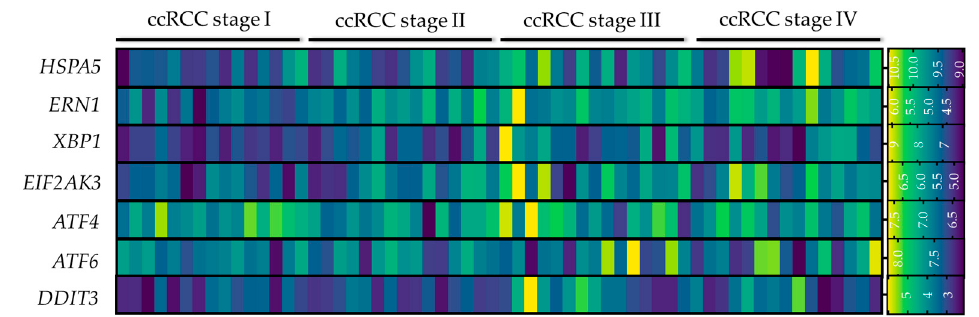
Figure 7. Expression of ER stress mediators in human ccRCC biopsies segregated in different stages. Heatmap representation of the expression of HSPA5 (encoding GRP78), ERN1 (encoding IRE1 α ), XBP1 , EIF2AK3 (encoding PERK), ATF4 , ATF6 and DDIT3 (encoding CHOP) in human ccRCC biopsies at stage I, II, III and IV ( n = 15/group). The data were acquired from the GEOdataset GSE150404 (expression profiling by microarray) and were analyzed via the GEO2R software. Graphical representation was designed with the GraphPad Prism 9 software.